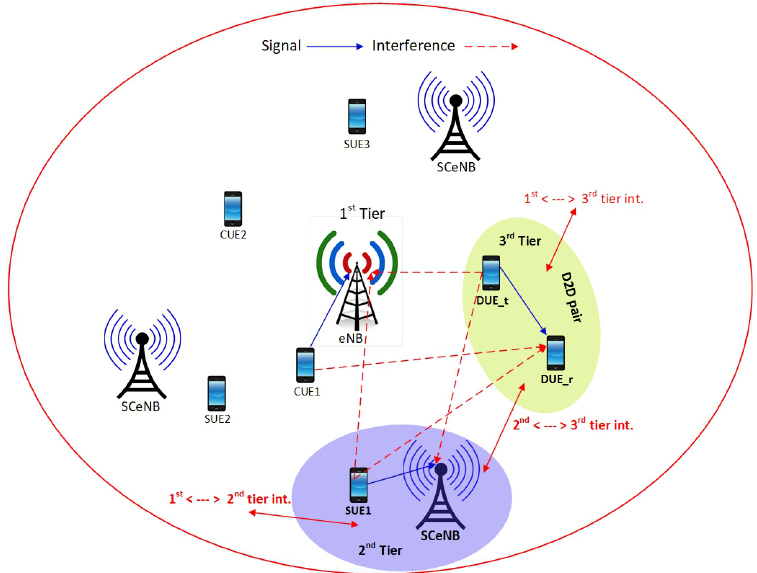
Figure 1. Interference scenario in a D2D-enabled three-tier cellular